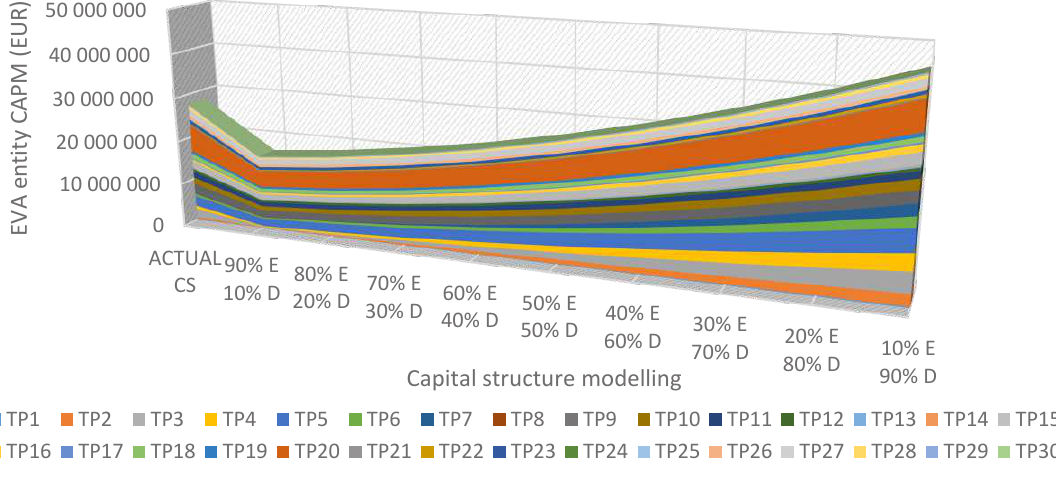
Figure 4. Development of the EVA entity indicator following the change in capital structure